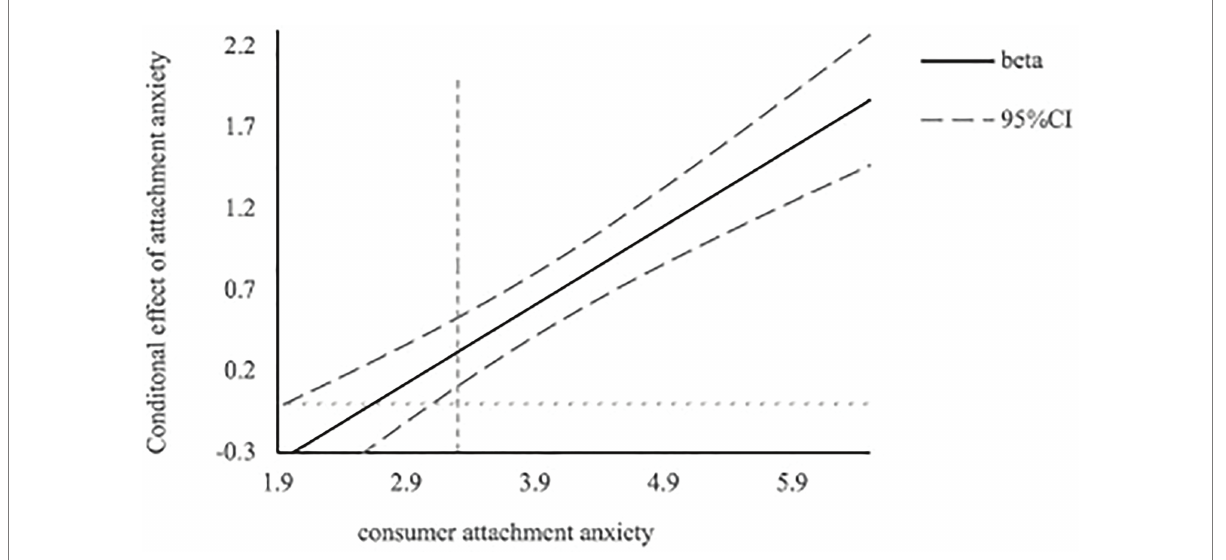
FIGURE 6 Johnson- Neyman analysis of consumer attachment anxiety for Study